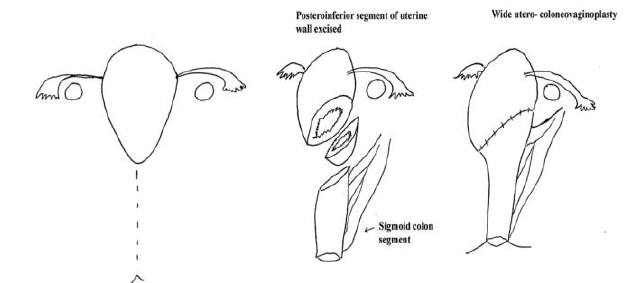
Figure 4: Uterocoloneovaginoplasty (Reproduced with per- mission from Kisku et al. Pediatr Surg Int. 2014;30:633-